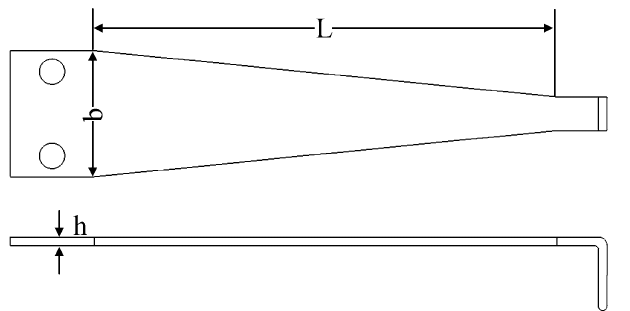
Figure 5. Structural schematic diagram of equal-strength cantilever beam (The figure was generated by Solidworks 2016 × 64 (https:// www. solid works. com/).